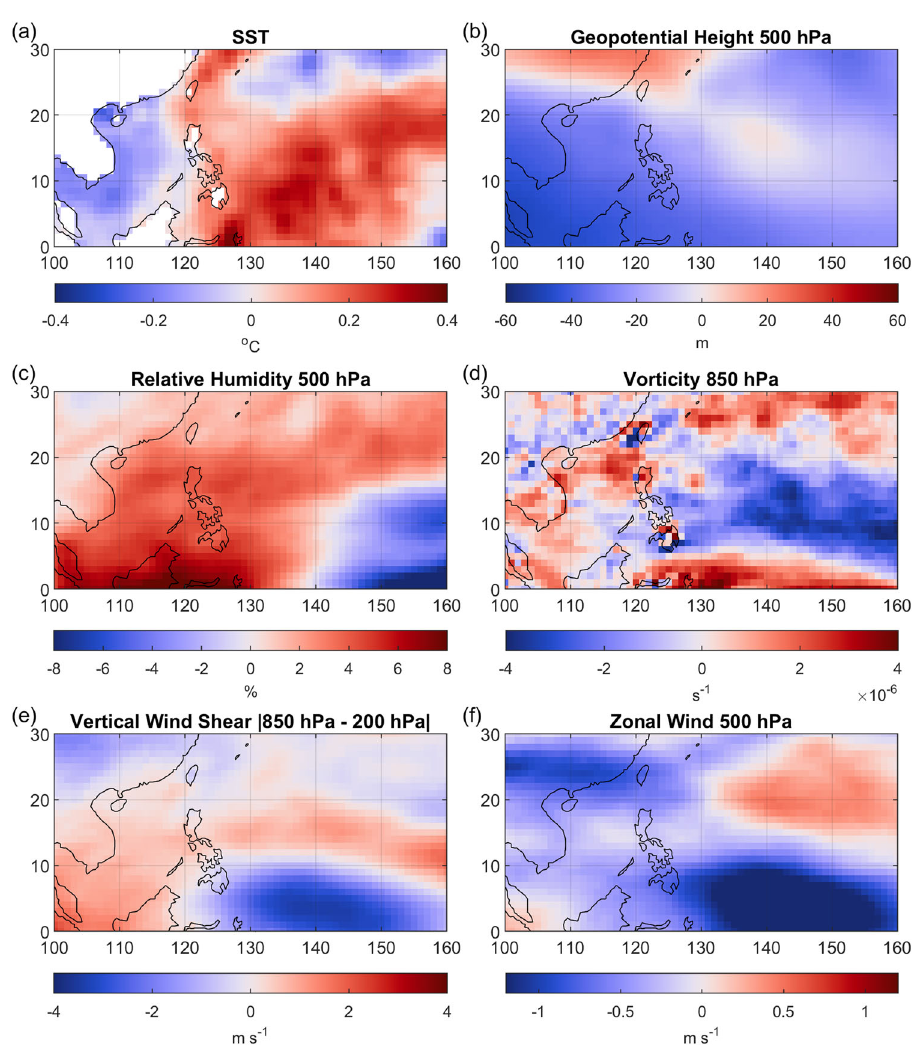
Fig. 4 Regional anomalies associated with low subNiño4 JJA-1 years. May – November anomalies of a SST, b geopotential height at 500 hPa, c relative humidity at 500 hPa, d relative vorticity at 850 hPa, e magnitude of vertical wind shear between 850 hPa and 200 hPa, and f zonal wind at 500 hPa. Anomalies calculated as difference between mean lower and upper subNiño4 JJA-1 tercile years. Lower and upper tercile thresholds are – 0.15 and 0.30 ∘ C, respectively.